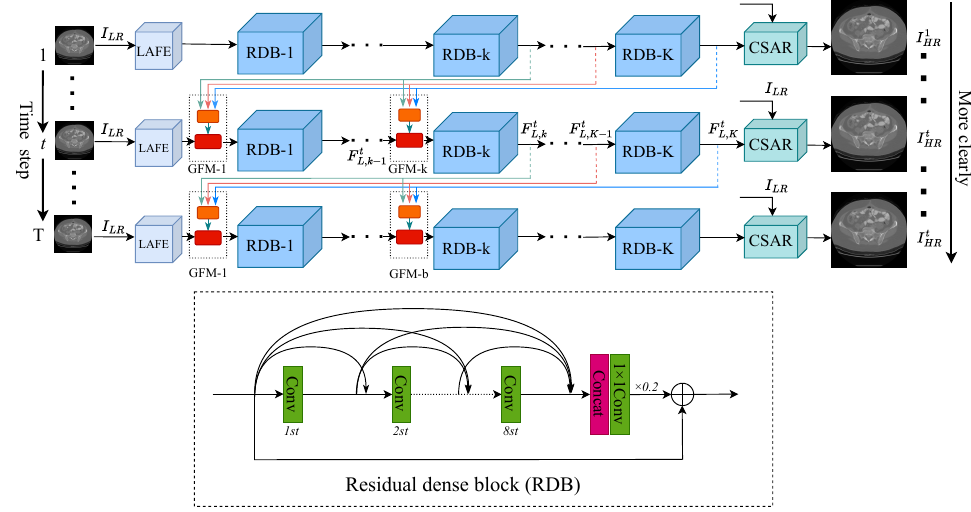
Figure 1. Framework of the proposed GAMA for medical image